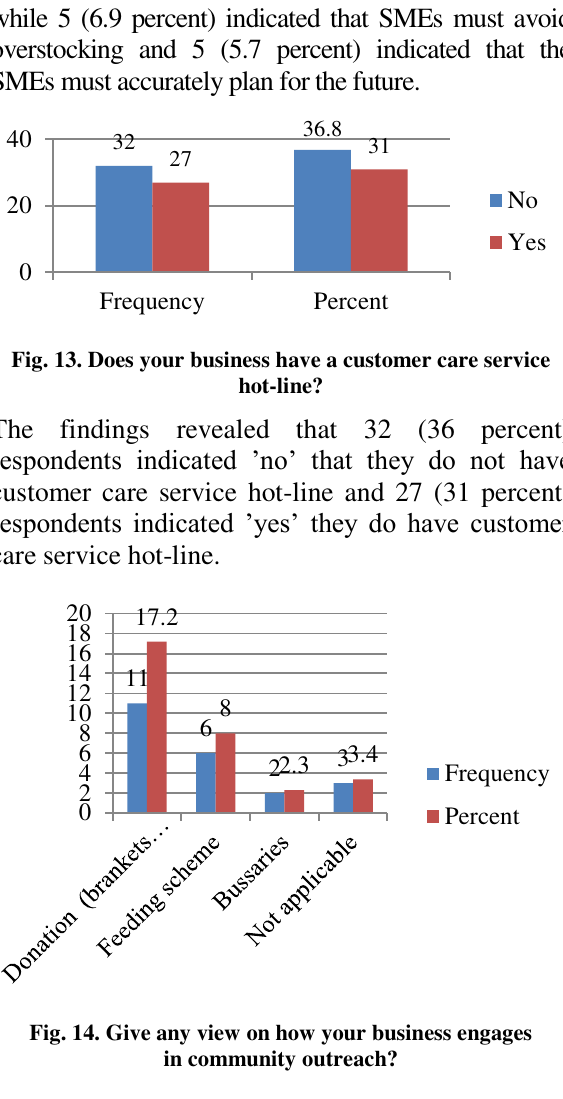
Fig. 10. Respondents about staff training and scheduled meeting?